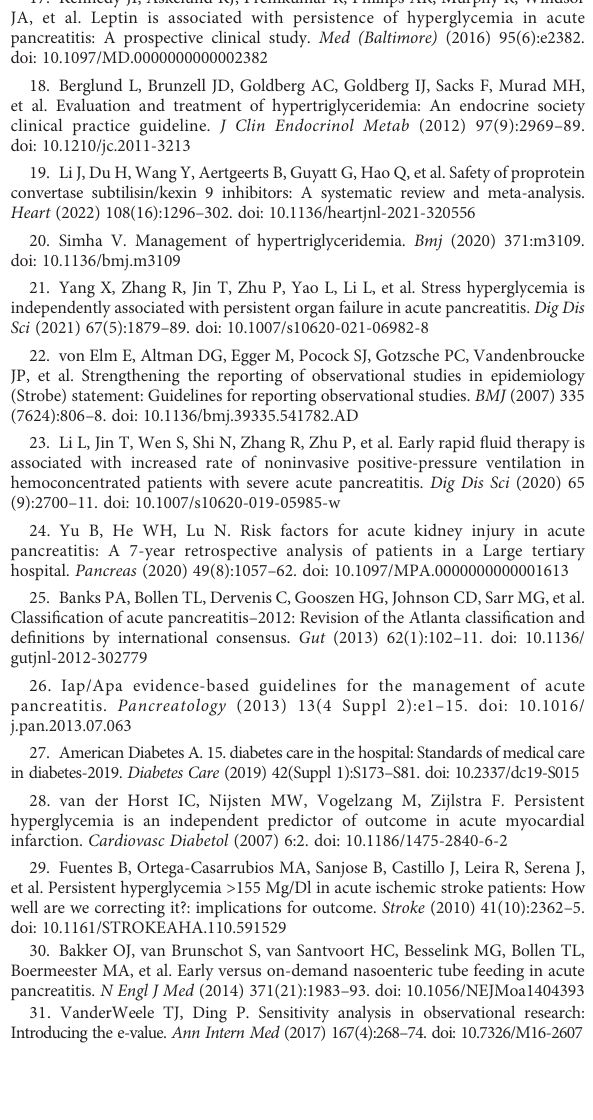
SUPPLEMENTARY FIGURE 2 Adverse clinical outcomes in patients with admission and persistent stress hyperglycaemia. SHG, stress hyperglycaemia; POF, persistent organ failure; MODS, multiple organ dysfunction syndrome; ANC, acute necrotic collection.